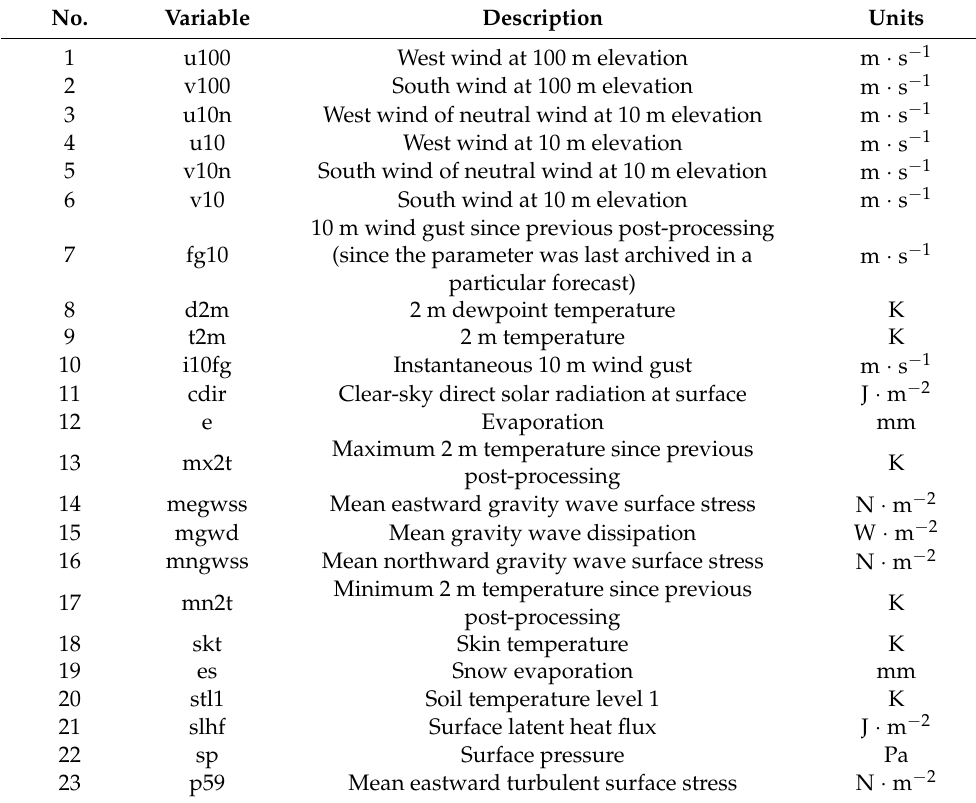
Table 1. The selection results of meteorological factors. No. Variable